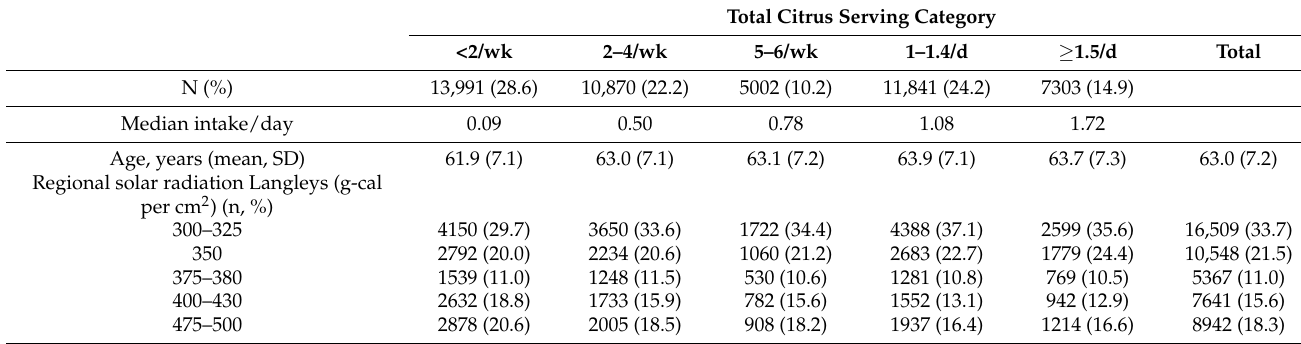
Table 1. Baseline characteristics of participants from the Women’s Health Initiative ( n = 49,007) according to the frequency of total citrus consumption.